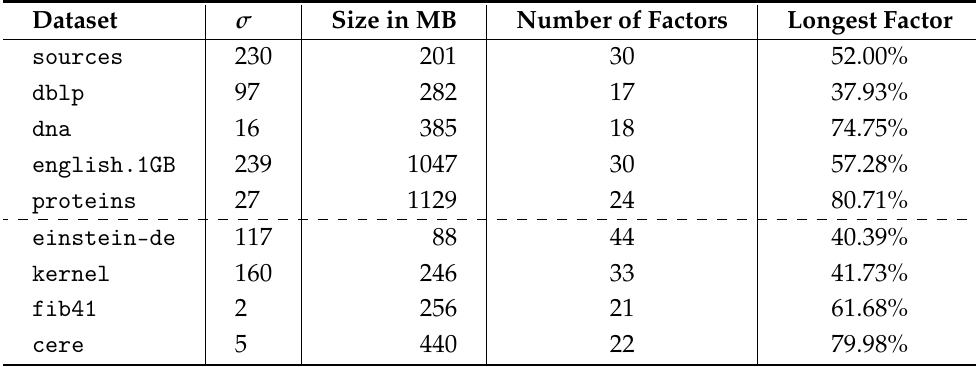
Table 1. Experiments with P IZZA &C HILI datasets considering the standard alphabet ordering. The datasets einstein-de , kernel , fib41 and cere are highly repetitive texts. The dataset english.1G is the first 1 GB of the original english dataset. Column 2 shows the alphabet